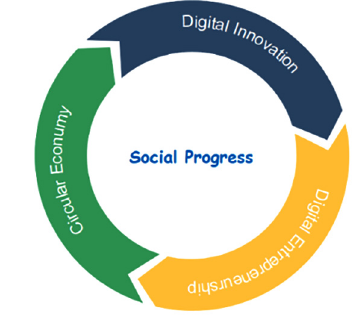
Figure 1. Prerequisites of social progress (source: created by the